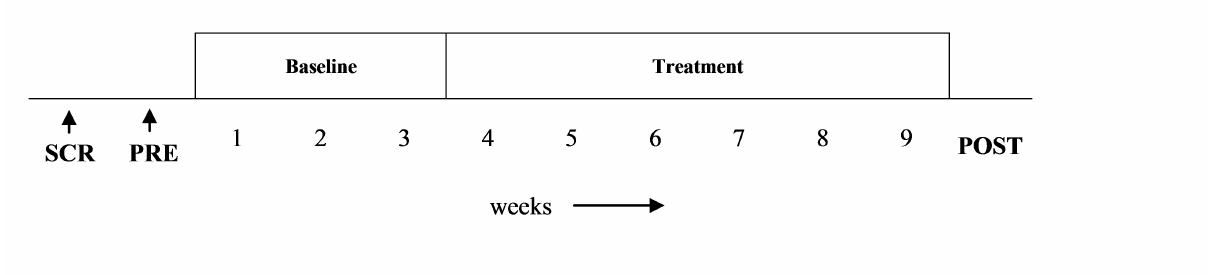
Figure 1. An overview of the study design. SCR: initial screening (MADRS-S), PRE: pretest (BDI-II, PTQ, WSAS), Baseline: baseline assessment with weekly ratings (MADRS-S, ISI), Treatment: intervention phase comprising assessment with weekly ratings (MADRS-S, ISI), POST: posttest (BDI-II, PTQ, WSAS, patient